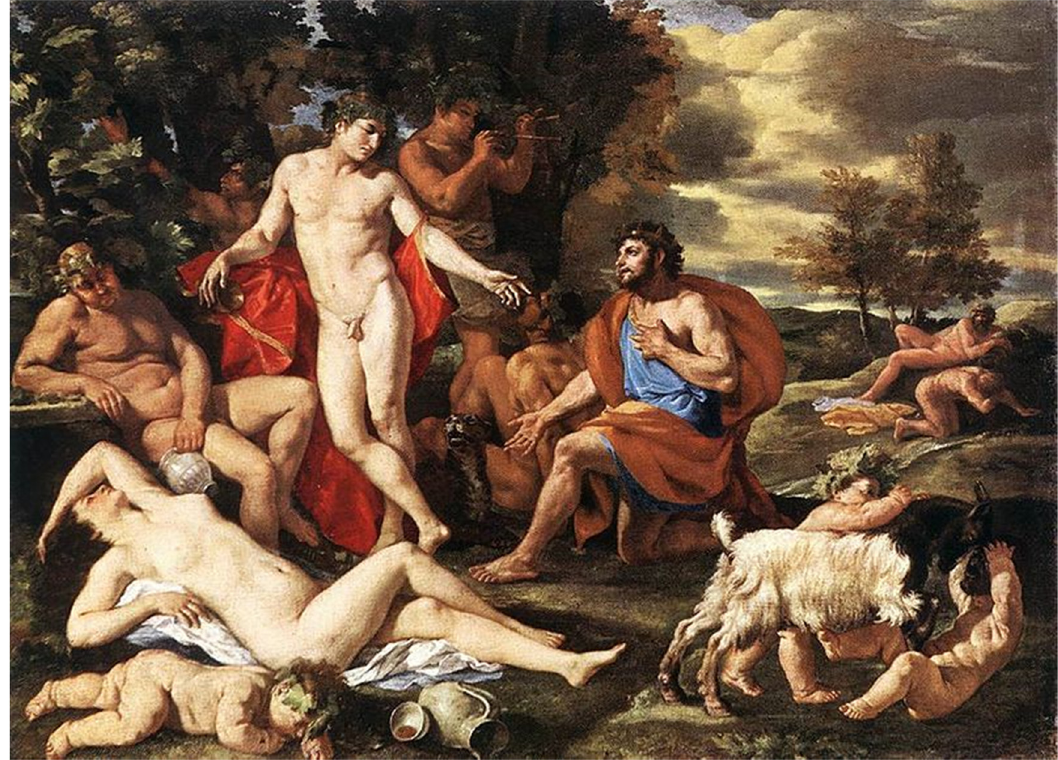
Figure 18: Nicolas Poussin, Midas and Bacchus , 1624. Alte Pinakothek, Munich. Public Domain.